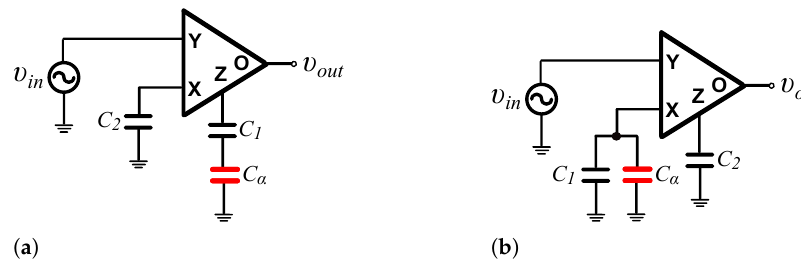
Figure 5. Implementations of fractional-order inverse ( a ) low pass, and ( b ) high pass filters.